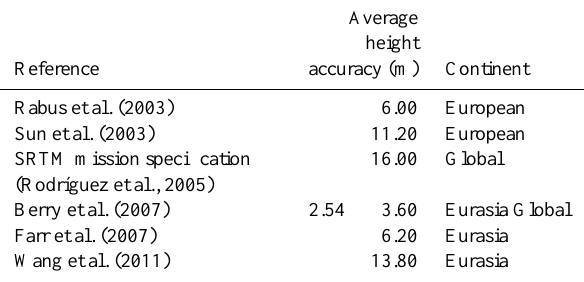
Table 4. Reported vertical accuracies of SRTM